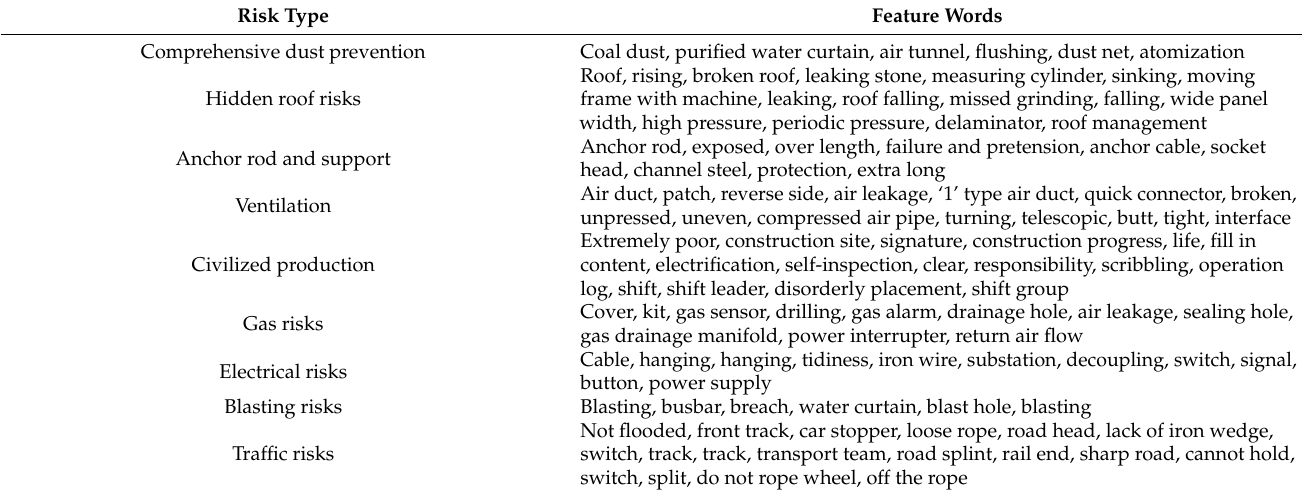
Table 2. Analysis results of main characteristic words of potential safety